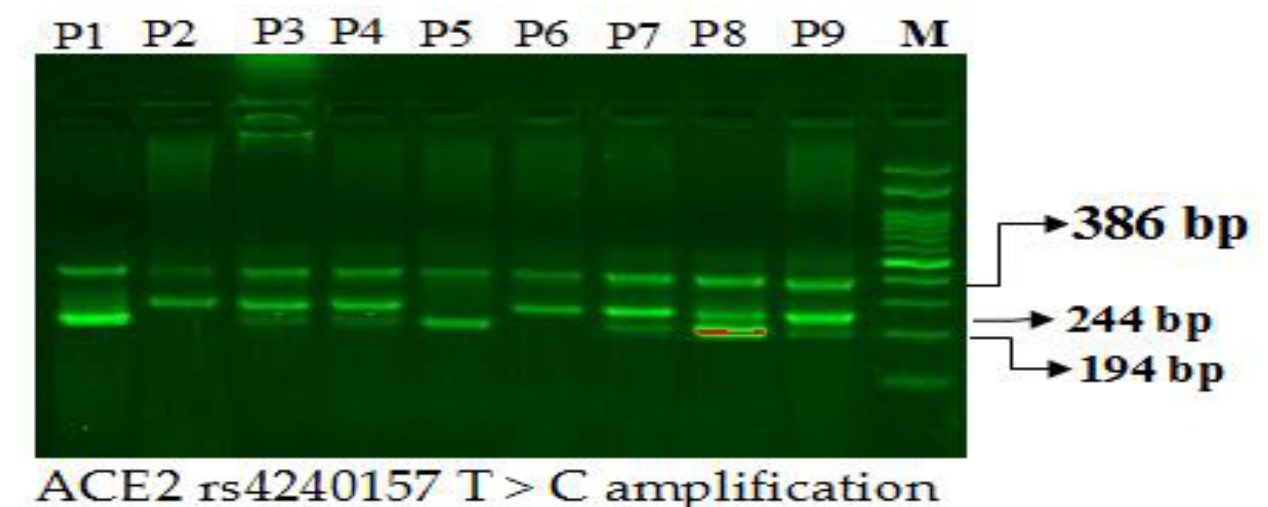
Figure 2. Optimization of Angiotensin-Converting Enzyme 2 genotyping ACE2 rs4240157T>C gene in coronary artery disease patients. Legend: M-100 bp DNA ladder; Heterozygous T/C-P3,P4,P7,P8 & P9; Homozygous CC-P1,P5; Homozygous TT-P2,P6.